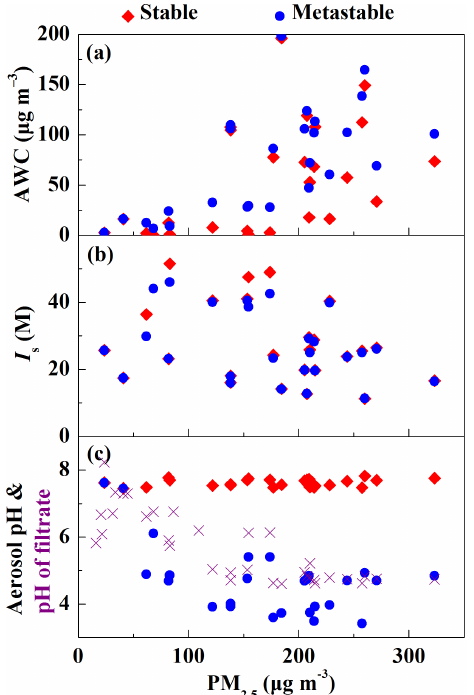
Figure 6. Aerosol parameters during Beijing haze. The aerosol liq- uid water content (AWC, a ), ionic strength ( I s , b ), and aerosol pH ( c ) was predicted by ISORROPIA II assuming stable aerosol state and metastable aerosol state. The pH of filtrate was measured using an ion activity